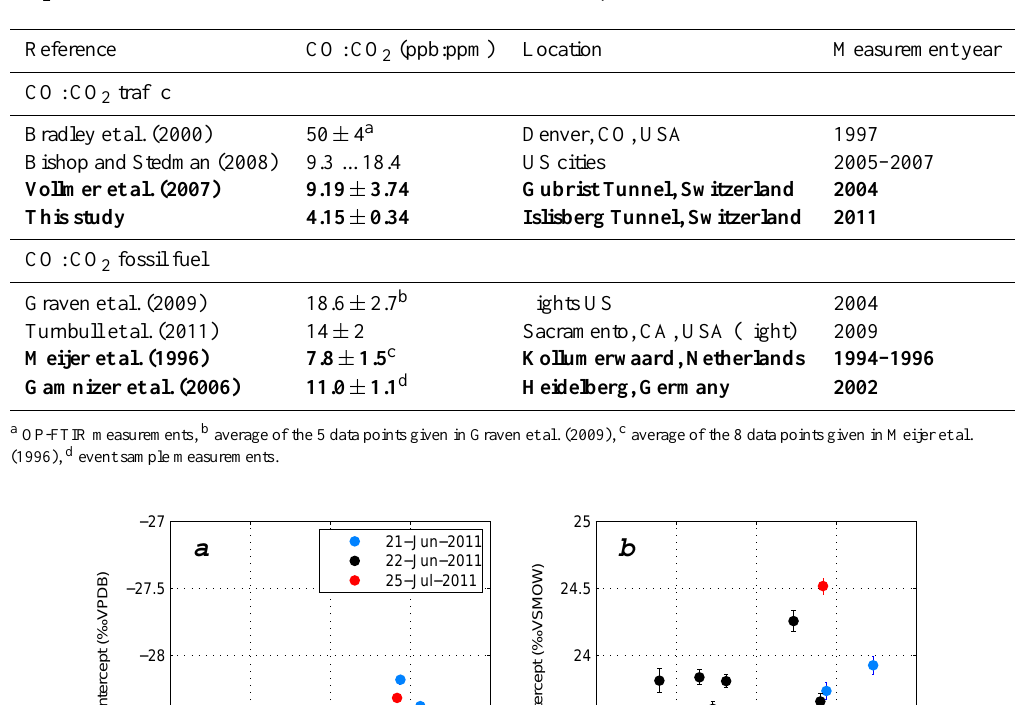
Table 1. CO:CO 2 ratios for traffic and fossil fuel emissions. Results from Europe are shown in bold.